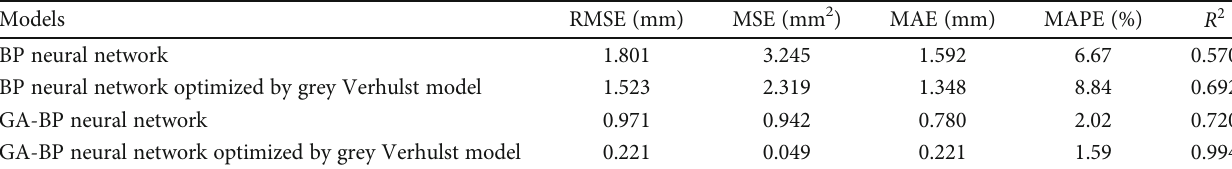
Table 3: Calculation results of performance indexes for these